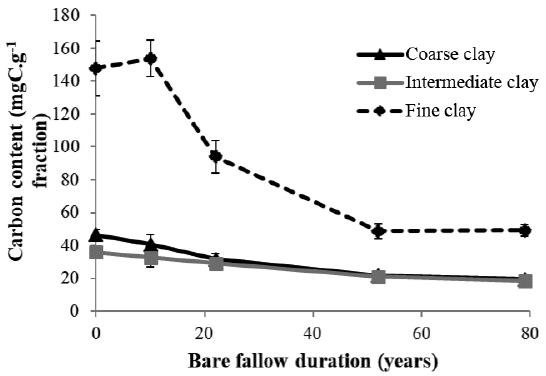
Figure 1. Evolution of carbon content (mgCg − 1 fraction) with time in the three different clay subfractions (error bars represent the stan- dard deviation observed over the four field replicates).